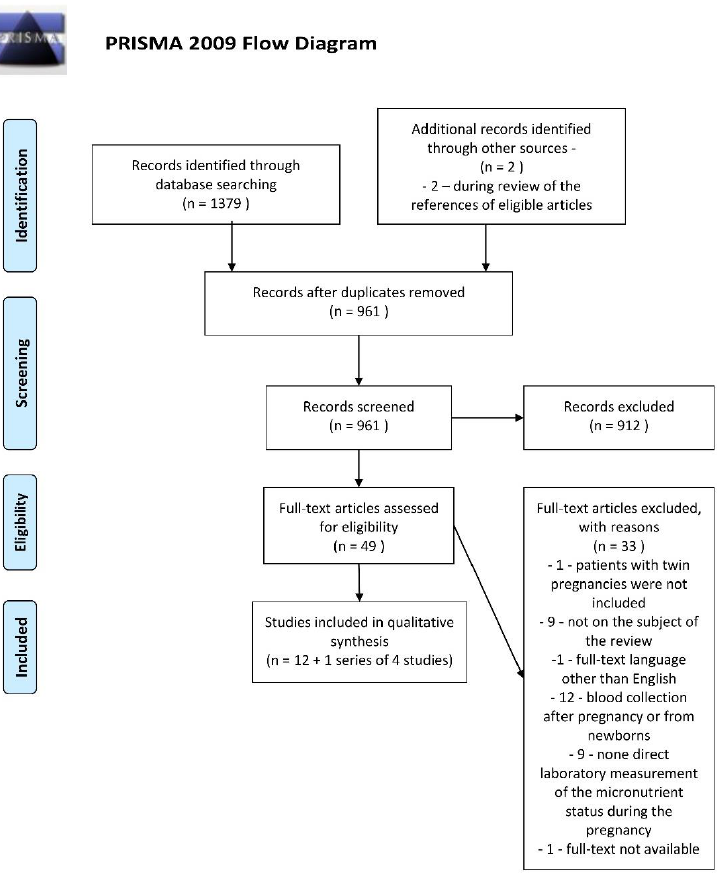
Figure 1. PRISMA Flow Diagram. From: Moher D, Liberati A, Tetzlaff J, Altman DG, The PRISMA Group (2009). Preferred Re-porting Items for Systematic Reviews and Meta-Analyses: The PRISMA Statement. PLoS Med 6(7): e1000097. doi: 10.1371/journal.pmed.1000097. For more information, visit: